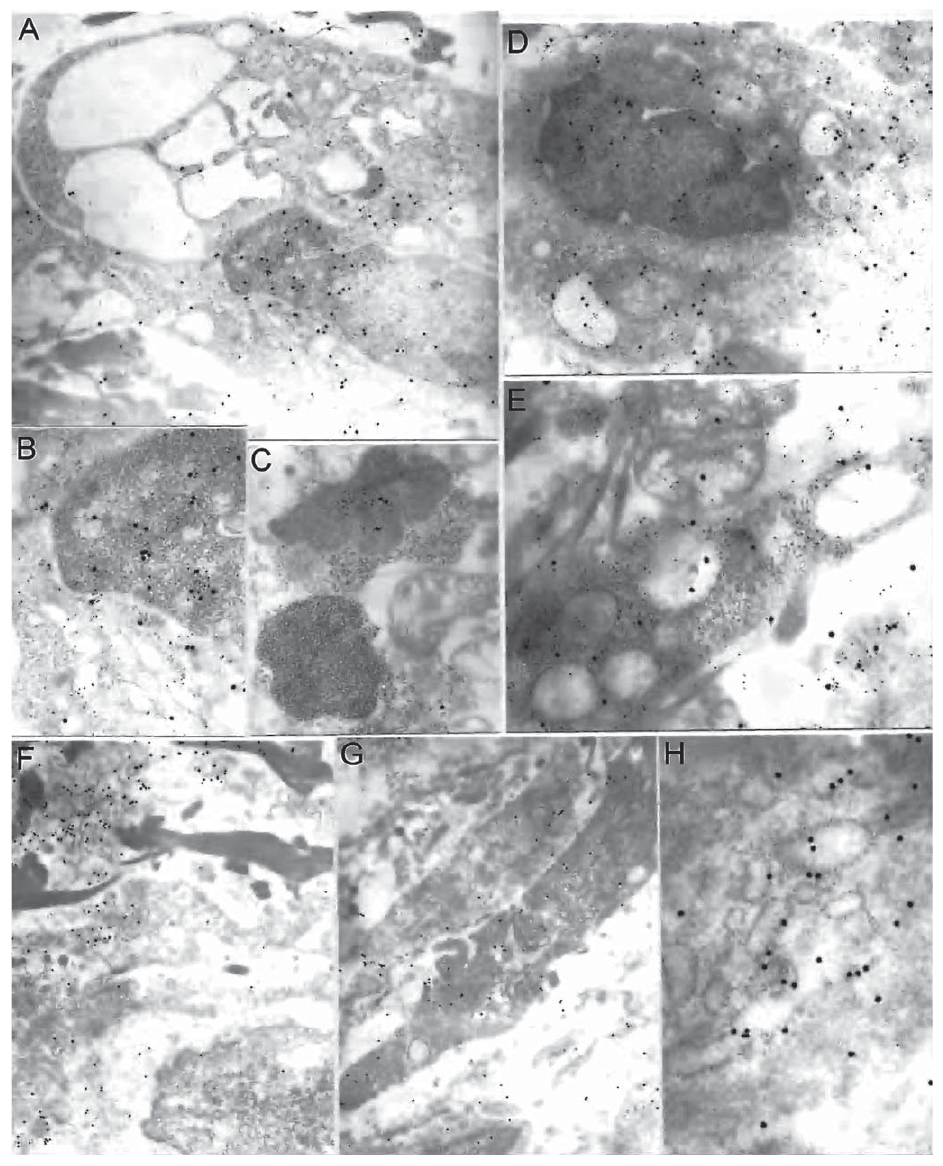
Fig. 6. Electron microscopy indicating WOX1/merlin (a–e) and p-WOX (f–h) expression in microcystic meningiomas. Double immunostaining (a–e)showsco-expressionofNF2/merlin(labeledby20nmanti-rabbitgoldparticles)andWOX1(10nmanti-goatgoldparticles).Largevesicles were found in these tumor cells. Note that the particles were primarily present in the nucleus or around the nuclear membrane (a, b). Some gold particles appeared in condensed nuclei (c). A similar pattern appeared in another cell (d). Note gold particles for WOX1 and merlin were also distributed in ribosomes, secretion-like vesicles and mitochondria (e). Further, p-WOX-labeled gold particles were also detected in the cytoplasm (f–h). Origin magnification: a, c, f, g,10,000X; b, d, e, h, 80,000X.